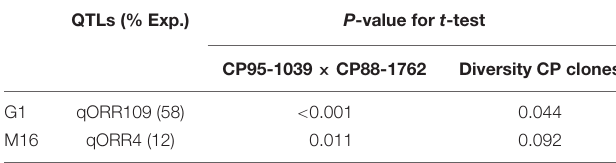
TABLE 5 | Probability ( P ) value PCR-based markers on orange rust resistance. QTLs (%